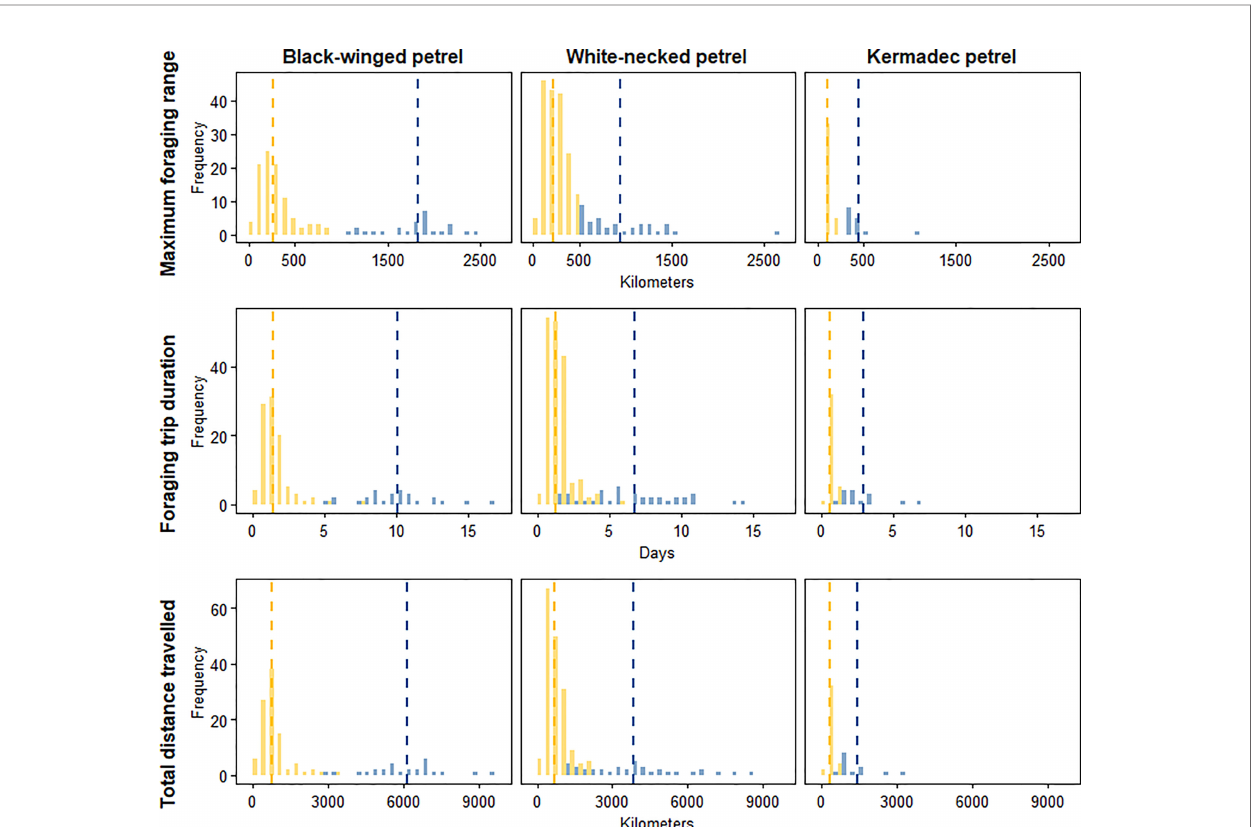
FIGURE 2 | Frequency distributions of maximum foraging range (km; upper row), duration of foraging trips (days; center row) and total distance traveled (km; lower row) for short trips (yellow) and long trips (blue) for black-winged petrels (left column), white-necked petrels (center column) and Kermadec petrels (right column). The dashed lines represent the mean of the frequency for short trips (yellow) and long trips